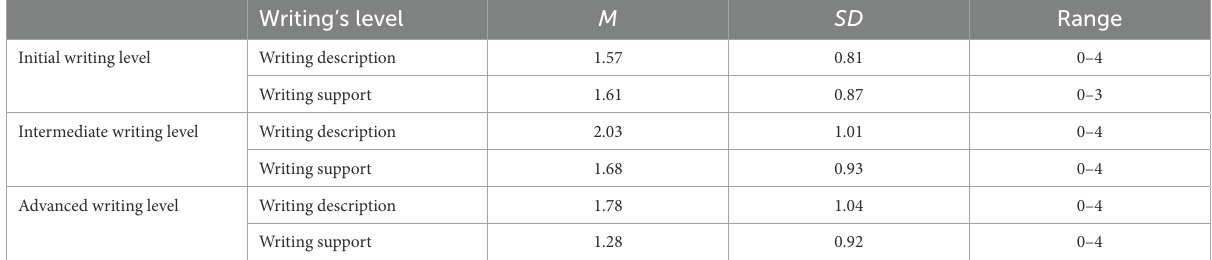
TABLE 3 Complexity: Number of aspects in parents’ description of the writings and in their writing support recommendations at the different writing levels ( N =